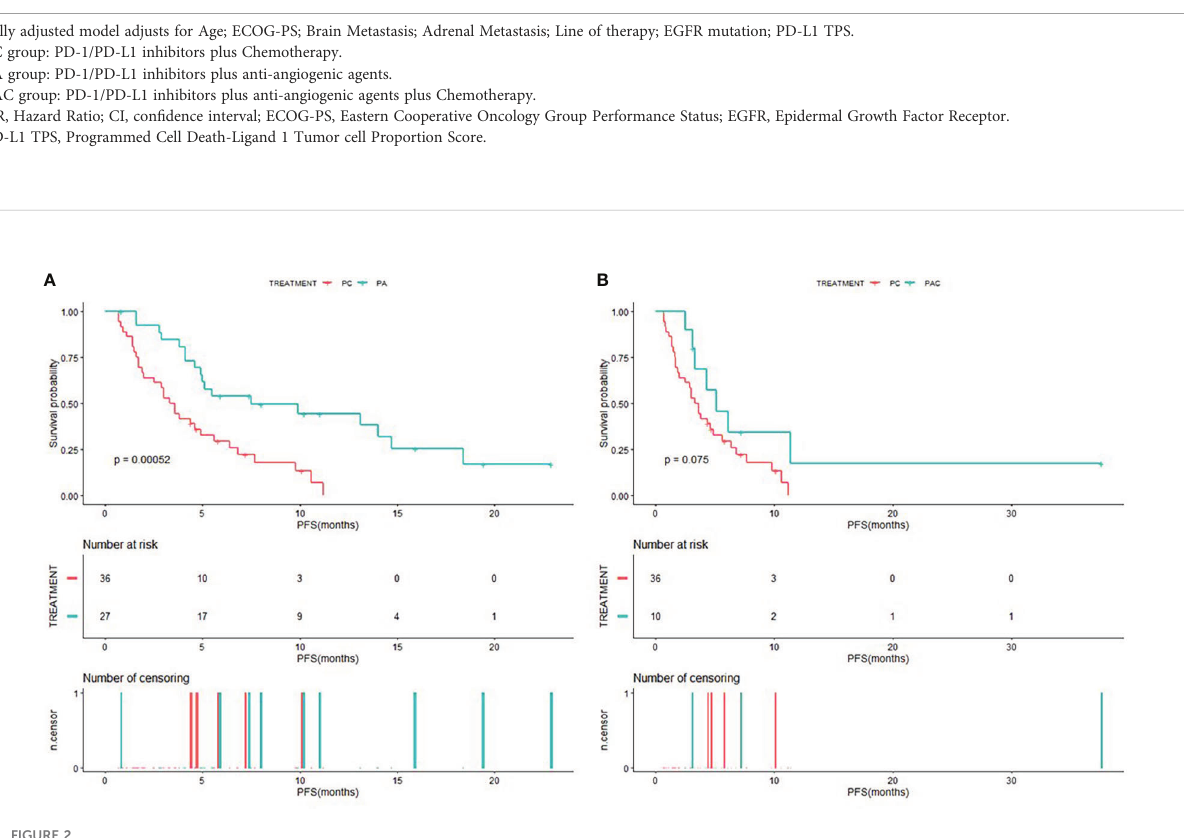
FIGURE 2 Kaplan-Meier (KM) curves of PFS (A) of patients in PC group versus PA group and PFS (B) of patients in PC group versus PAC